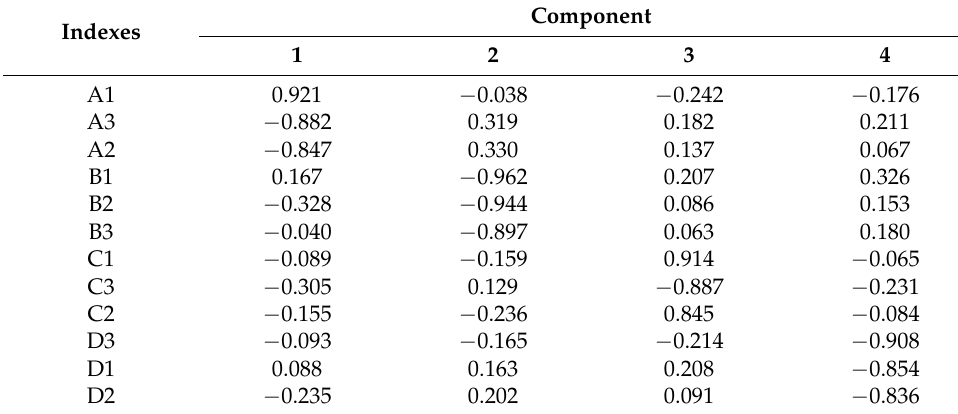
Table 5. Rotated component matrix.